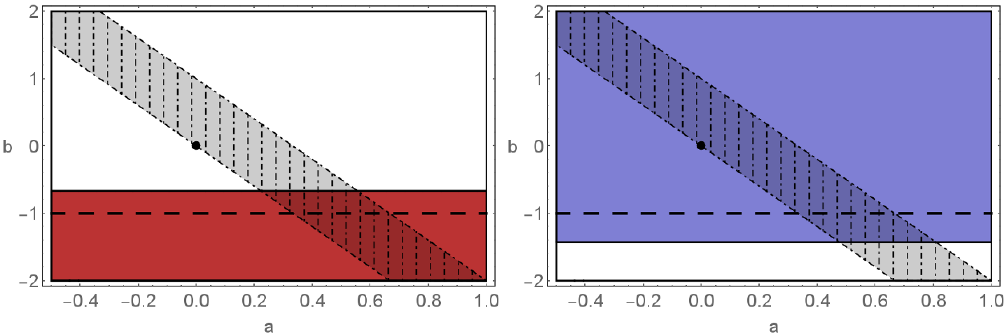
Figure 7 . We show the regions where f y > 0 (red, left panel) and f g > 0 (blue, right panel). In both panels, the gray strip (with vertical dot-dashed lines) show the region were the TT-approximation di(cid:11)ers from the full result. The horizontal dashed line indicates the pole 1 + b =